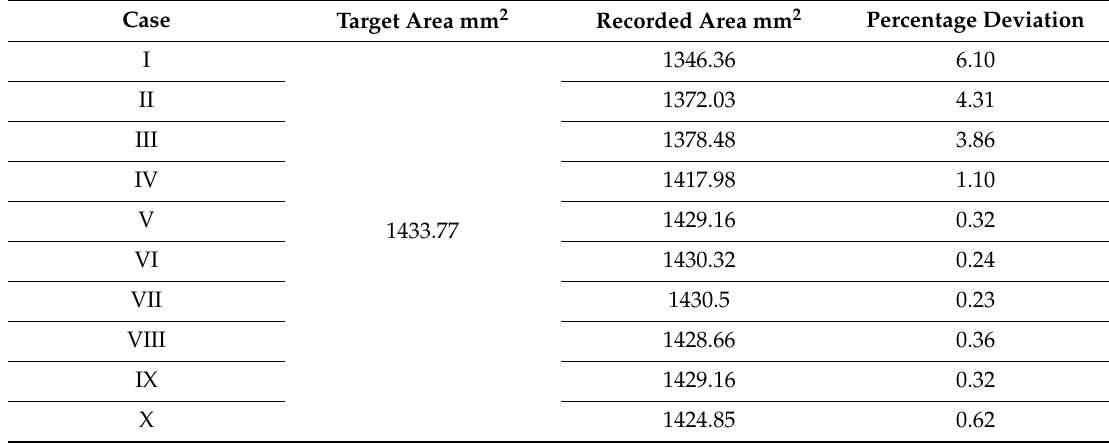
Table 5. Percentage of Deviation from Targeted